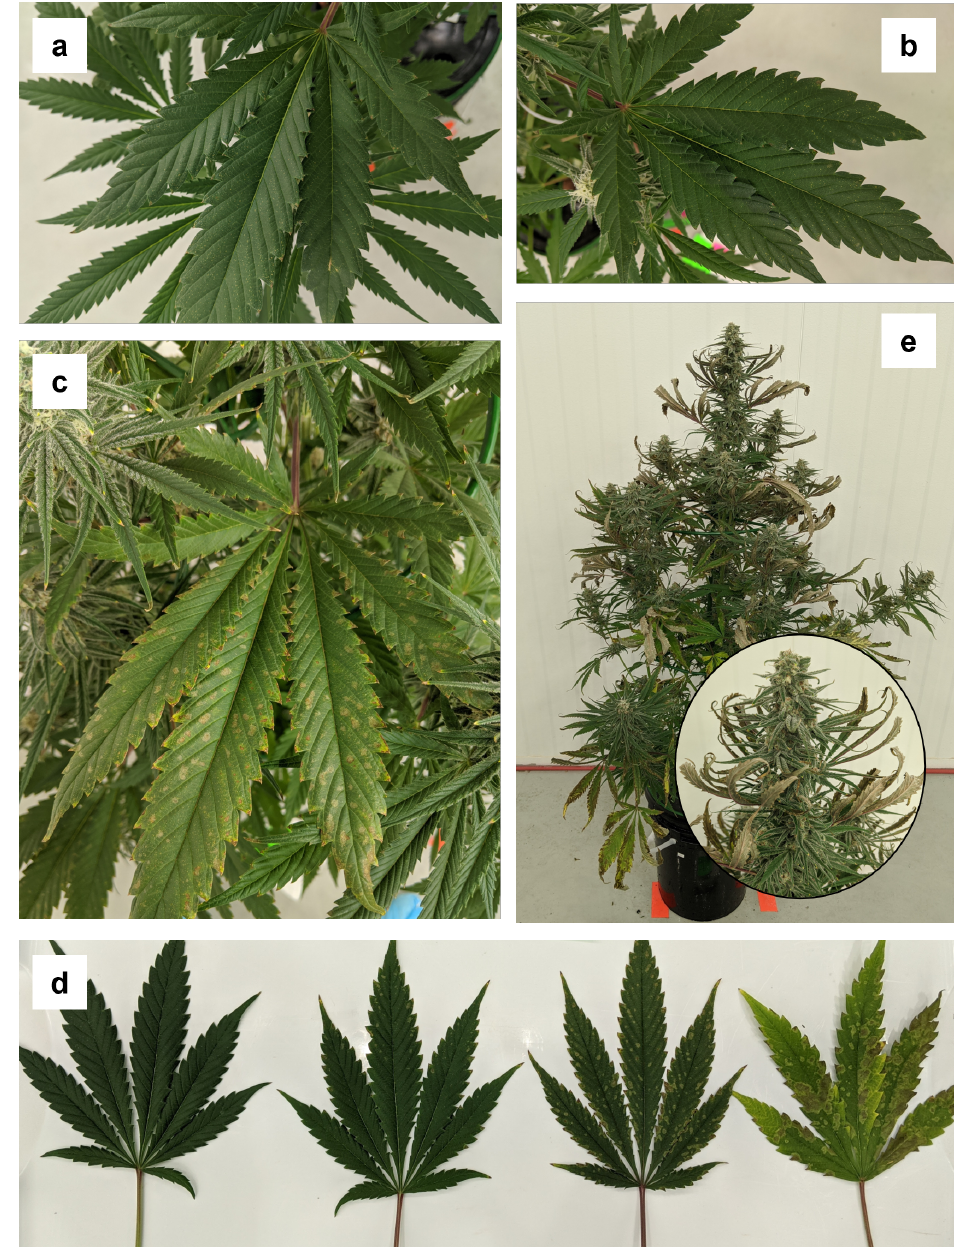
Figure 3. Progression of foliar phosphorous (P) deficiency symptoms in fan leaves during week three ( a ), week four ( b ), and week five ( c , d ) and phosphorous deficiency symptoms on the whole plant ( e ) and sugar leaves associated with the apical inflorescence (( e ),